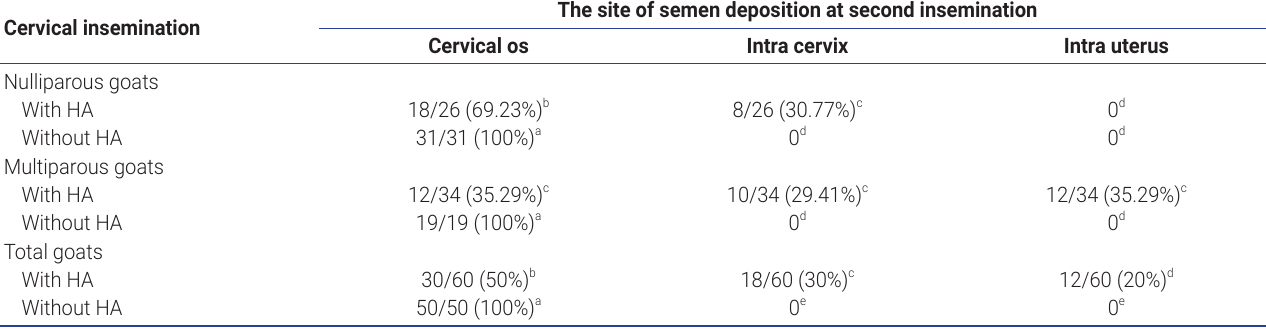
Table 3. The number and percentage of nulli- and multi-parous goats according to the site of semen deposition within the reproductive tract at the second insemination (56 h after sponge removal) The site of semen deposition at second insemination Cervical insemination Cervical os Intra cervix Intra